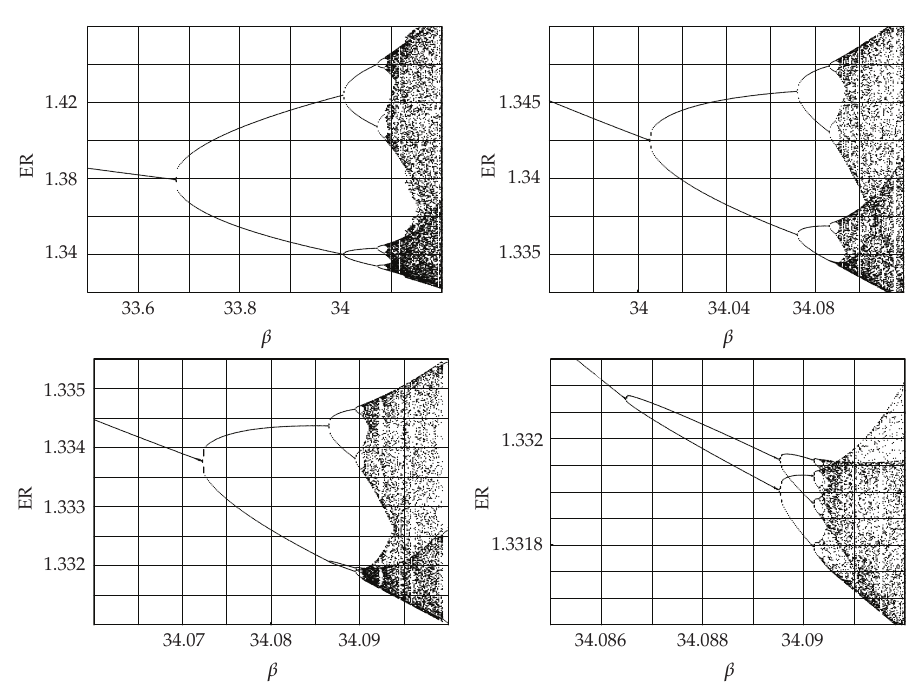
Figure 15: Details of Figure 14 (cid:4) four levels of magnification (cid:7) . The period-doubling process to chaos for Z (cid:9) 35, δ (cid:9) 0 . 4, α (cid:9) 1 .